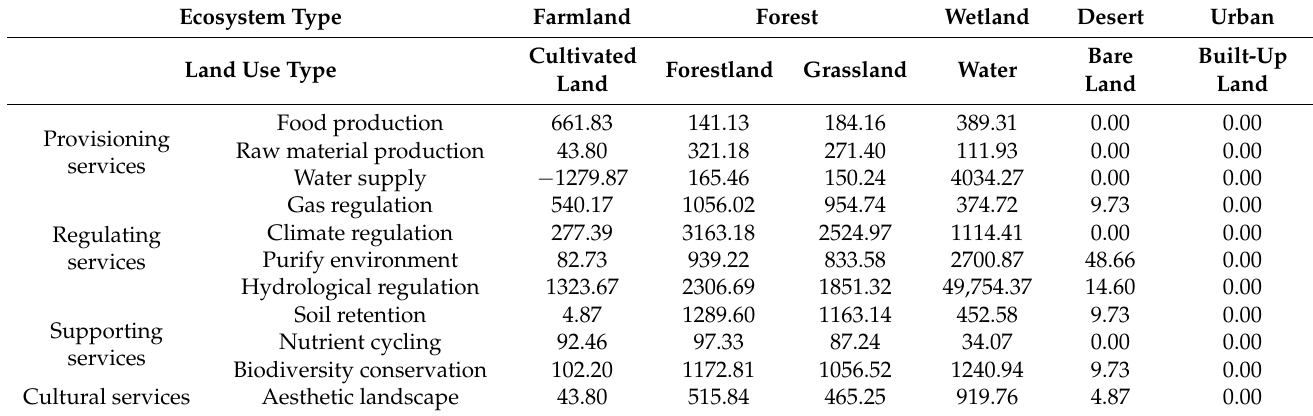
Table 2. Ecosystem service equivalent value per unit area